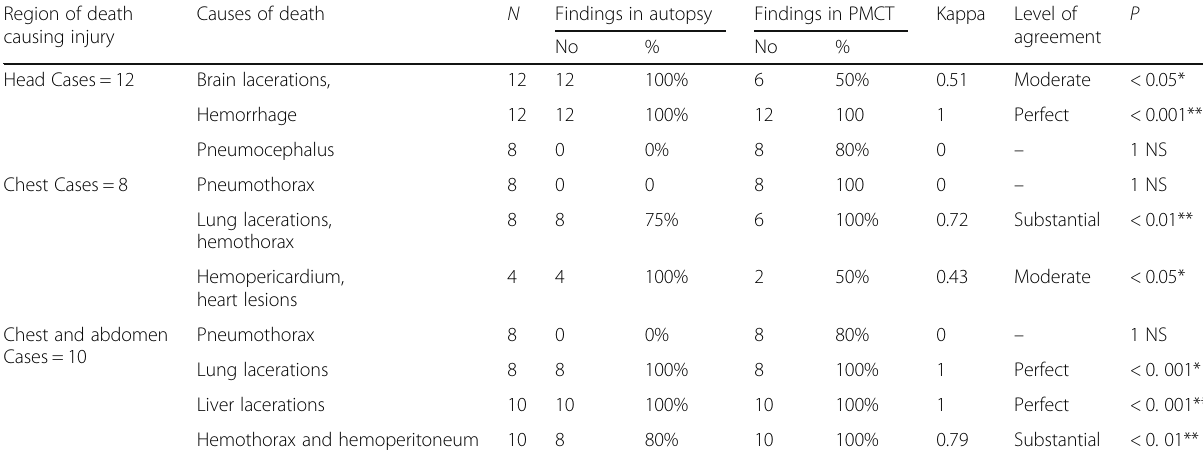
Table 3 Degree of agreement between PMCT and autopsy in detection of causes of death in firearm injuries by Kappa